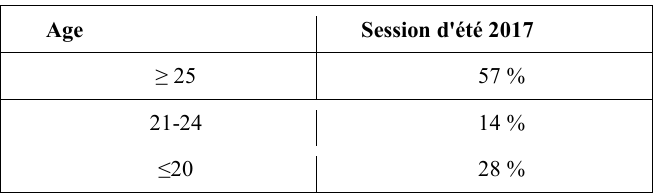
Tableau 3. Pourcentage des inscrits selon la tranche d’âge pour la session d’été